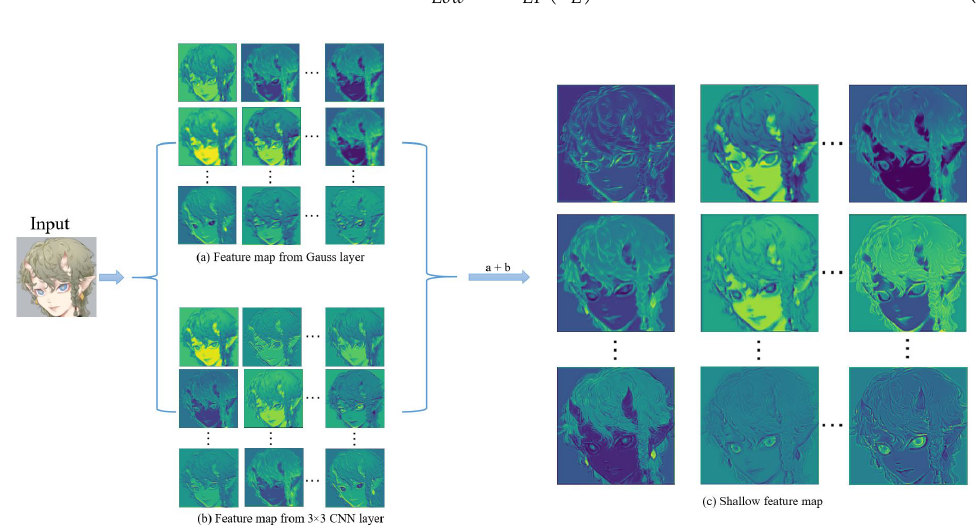
Figure 8. Feature maps extracted by different parts of the shallow feature extraction